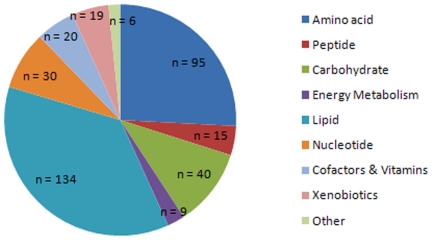
Class distribution of identified metabolites.n = number of metabolites in each class.